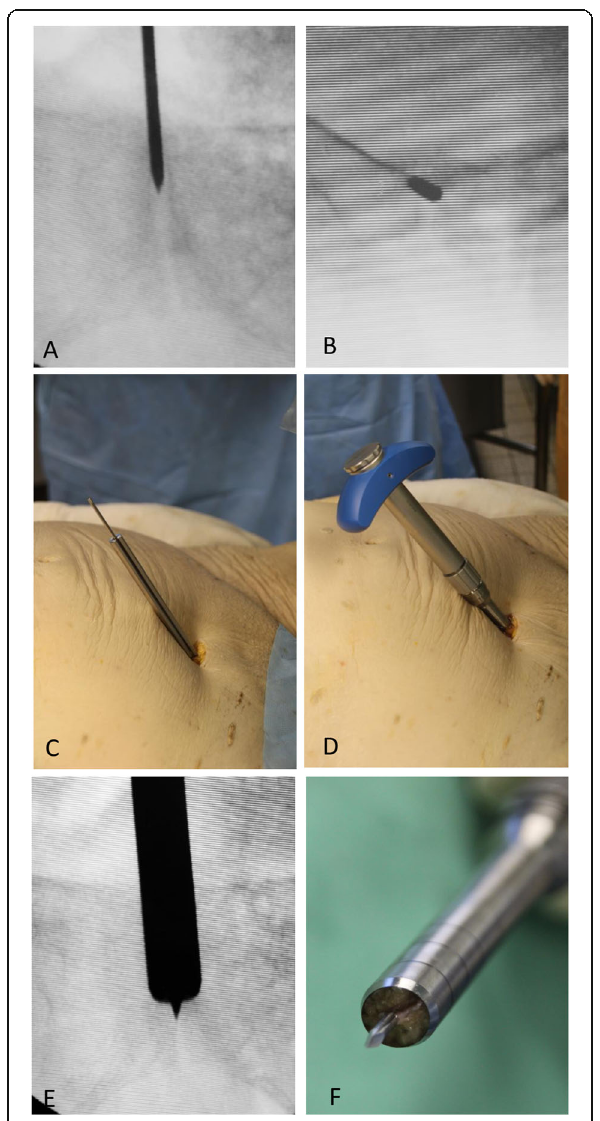
Fig. 2 a and b : Placement of the guidewire inside the pubic symphysis using inlet & outlet radiographs c Using the centering device across the guidewire and pushing it down onto the bony part of the symphysis d Using the novel modified bone harvester with fins, that is centered and driving it into the bone using a hammer e Inlet-radiograph, showing the correct positioning of the bone harvester, also leaving the caudal part and the caudal ligaments of the pubic symphysis intact f The harvested pubic symphysis inside the bone harvester with the guidewire inside the pubic symphysis